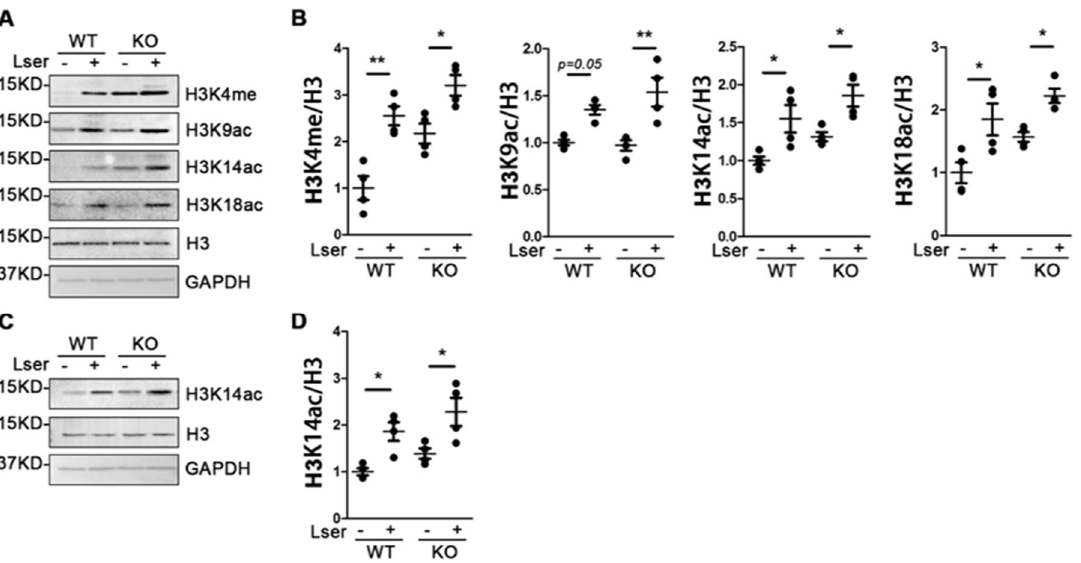
Figure 5. Enriched profile of histone H3 modifications in GHRH-KO mice and wild type controls with L-serine intervention. GHRH-KO mice and age-matched wild type controls were subject to L-serine oral administration for 12 weeks. The mice were euthanized and tissue-specific crude synaptosome was extracted for immunoblot analyses. ( A ) Immunoblots of crude synaptosome in the hippocampus are shown for H3K4me, H3K9ac, H3K14ac and H3K18ac. ( B ) Quantification of hippocampal H3K4me, H3K9ac, H3K14ac and H3K18ac activation with L-serine supplementation for 12 weeks in both genotypes. ( C ) Immunoblot of crude synaptosome in the cerebral cortex is shown for acetylation of H3K14. ( D ) Quantification of cerebral cortical H3K14ac activation with L-serine supplementation for 12 weeks in both genotypes. n = 4 mice per group. Data represent means ± SEM. * p < 0.05, ** p < 0.01.